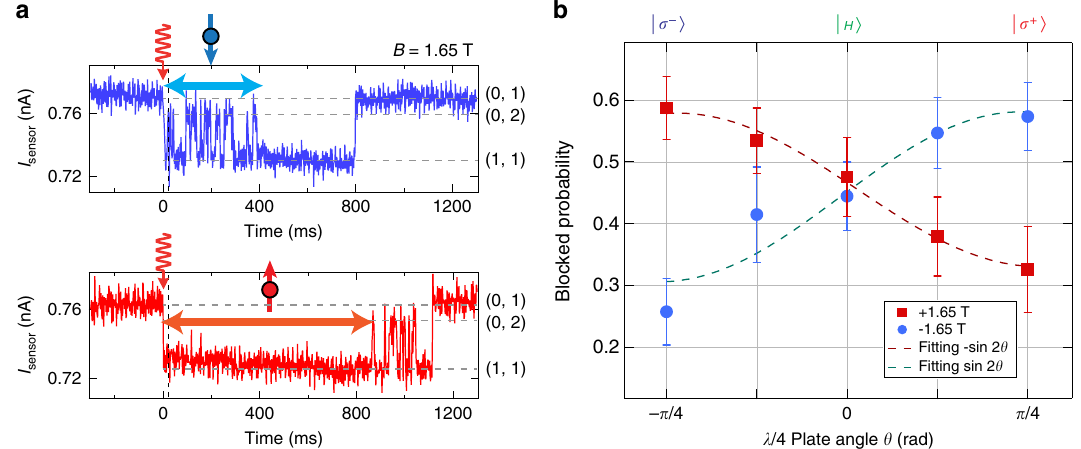
Fig. 3 Single photo-electron spin detection and angular momentum transfer. a Two typical I sensor traces of photo-electron trapping, indicating down-spin trapping in the upper panel, and up-spin trapping in the lower panel, respectively. b Polarization and fi eld polarity dependence of the blocked probability, re fl ecting the angular momentum transfer from a single photon to an electron spin. A sinusoidal dependence is observed against the rotation angle θ of polarization from − π /4 to π /4. By reversing the external magnetic fi eld or reversing the polarity of the spin detection axis, we observe a fl ipped curve. This means that a single photon polarization creates a single fi xed electron spin in the dot, following the conversion rule depicted in Fig. 1a. Each data point is derived from the single-shot measurements repeated more than 1000 times. The photo-electron trapping rate averaged over all measurements is 3%. The error bars ~5% are the standard deviation of the binomial distribution for each measurement point. From the fi tting to the sinusoidal curve an amplitude of 25 ± 2% (27 ± 5%) and an offset of 45 ± 1% (44 ± 2%) for B = 1.65 T ( − 1.65 T) are obtained. We used these parameters for fi delity